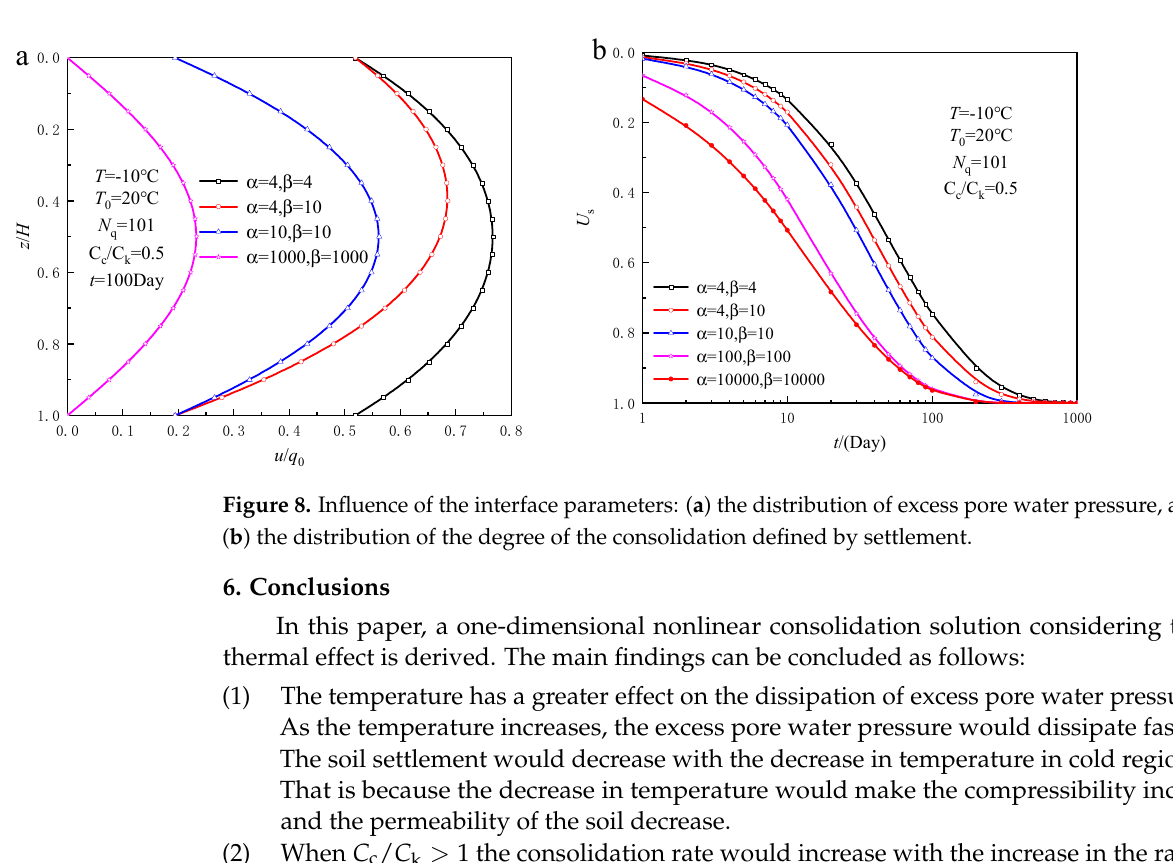
13 of 15 Figure 7. Influence of the pile of c k C C : ( a ) the distribution of excess pore water pressure, and ( b ) the distribution of the degree of the consolidation defined by settlement. 5.5. Influence of Interface Parameter α and β As is shown in Figure 8, the excess pore water pressure would dissipate dramatically